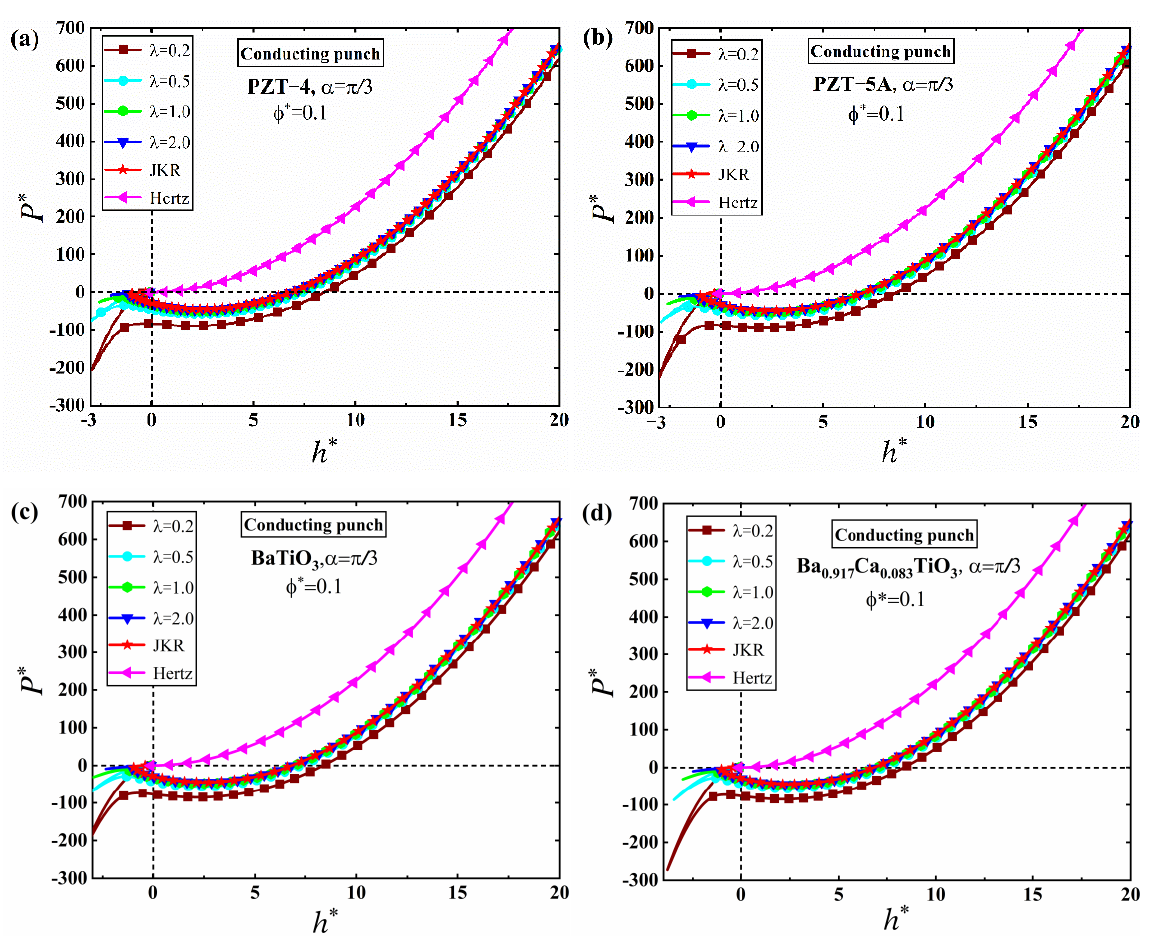
Figure 18. The dimensionless indentation force, P ∗ , as a function of the dimensionless indentation depth, h ∗ , under the action of a conducting punch for the M-D model. ( a ) PZT-4. ( b ) PZT-5A. ( c ) BaTiO 3 . ( d ) Ba 0.917 Ca 0.083 TiO 3 .